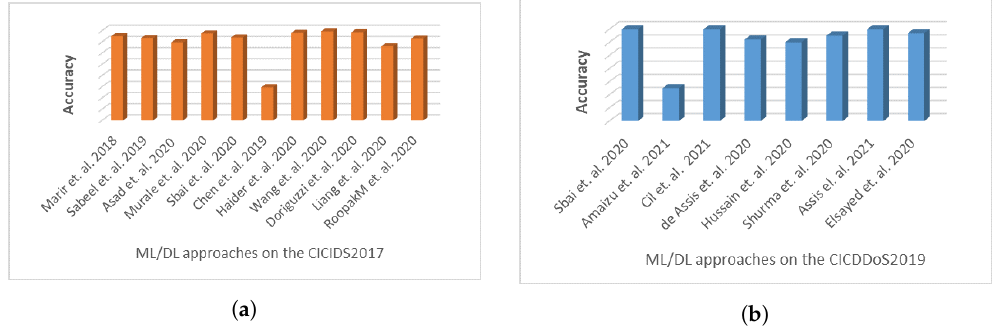
Figure 5. Accuracy of the studied ML/DL approaches on ( a ) the CICIDS2017 dataset [38,49,53,55– 57,62,64,65,67,72] and ( b ) the CICDDoS2019 dataset [37,42,53,58,59,68,69,73].